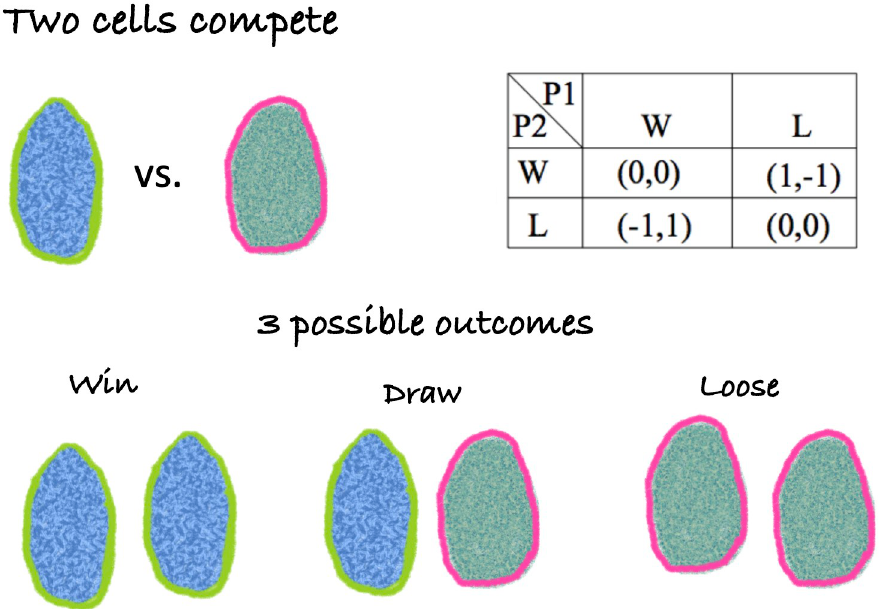
Fig 1. Competition occurs on a cell-to-cell level. When two asexually reproducing individuals compete in a zero-sum game, there are three possible outcomes for each individual: win = self-replicate; draw = maintain status quo for each competitor; lose = die/competitor replicates. The table shows the pay-off function of individual-level competition. A payoff of 1 corresponds to win, a payoff of -1 corresponds to lose, and a payoff of 0 corresponds to a draw.